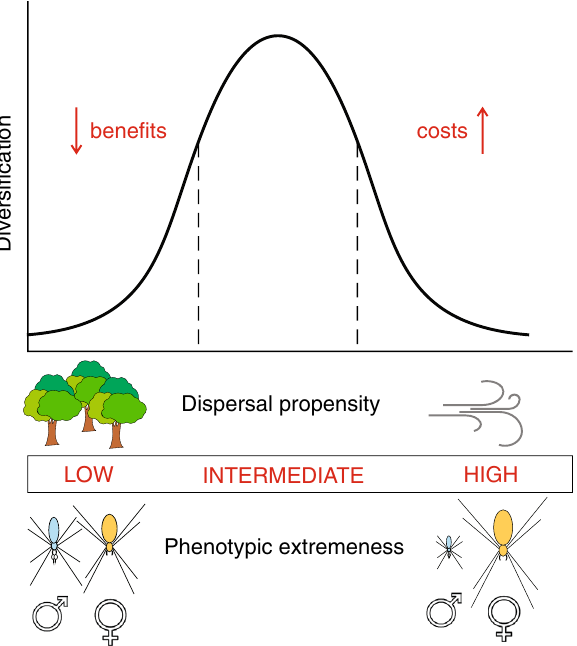
Figure 2. The hypothesised bell-shaped relationship between diversification and two continuous factors, dispersal propensity and body length sexual dimorphism. We test the prediction that intermediately expressed phenotypes will exhibit the highest rates of